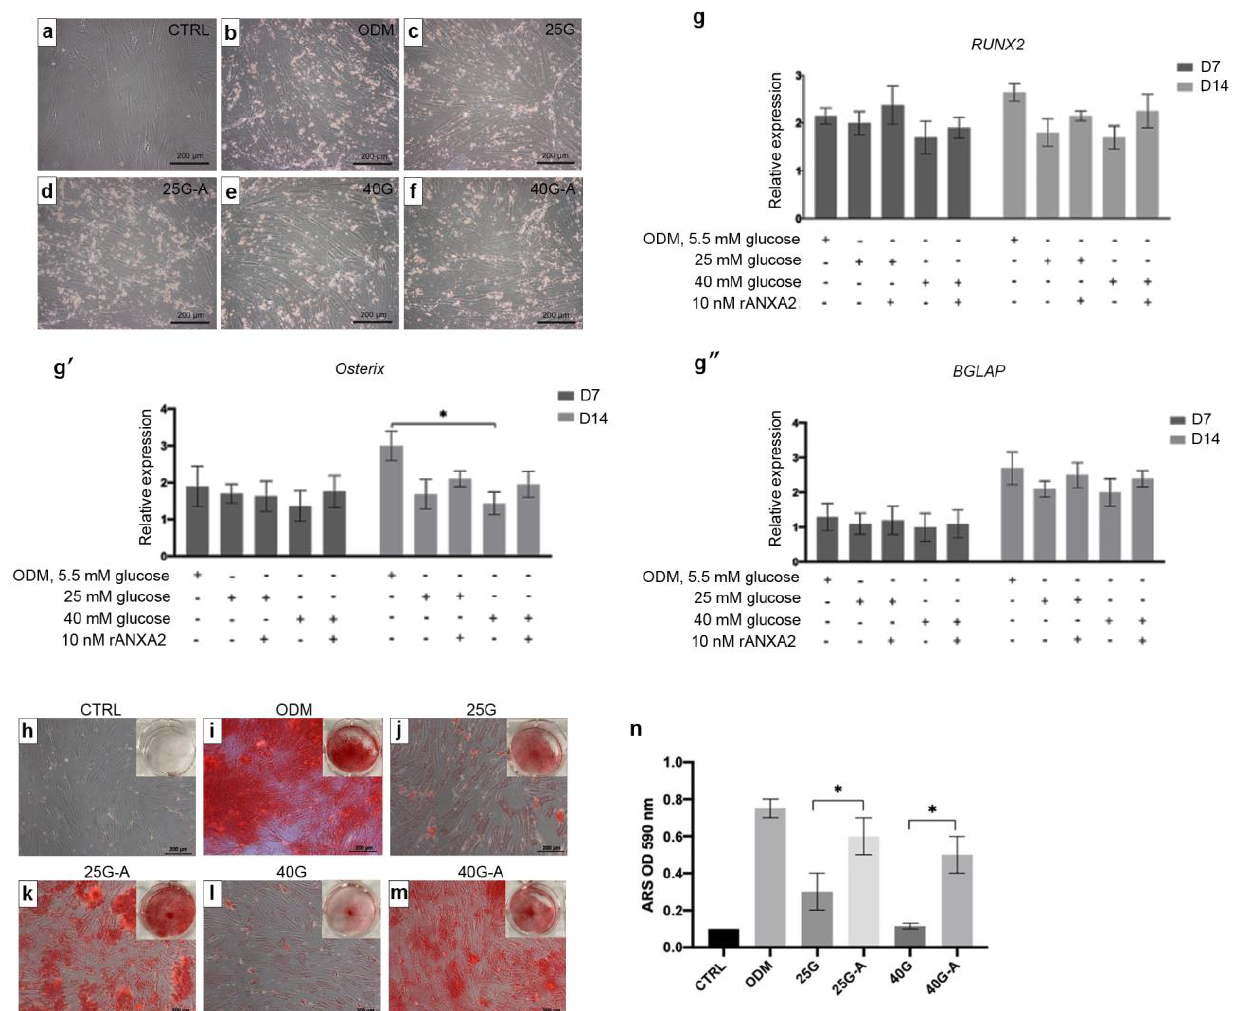
Figure 4. Effect of annexin A2 on MSC osteoblastic differentiation under high-glucose conditions. The recombinant annexin A2 (rANXA2) was added to the ODM with 25 mM glucose (25G-A) and ODM with 40 mM glucose (40G-A) condition. The morphology of MSCs in growth medium (control, CTRL) and in ODM under normal and high-glucose conditions with/without rANXA2 was observed ( a – f ). The transcriptional levels of RUNX2 ( g ), Osterix ( g ’ ), and BGLAP ( g ’’ ) at day 7 and 14 were determined. Gene expression is presented as relative expression to CTRL. At day 14, matrix mineralization by ARS staining was evaluated ( h – m ). The accumulation of ARS was extracted and measured at optical density 590 nm ( n ). Data are presented as the means ± SEM from three independent experiments. * p value < 0.05 is considered statistically significant.